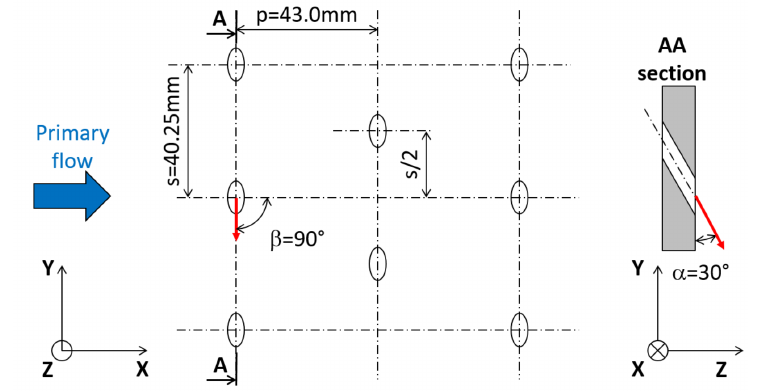
Figure 2. Geometrical parameters of the perforated